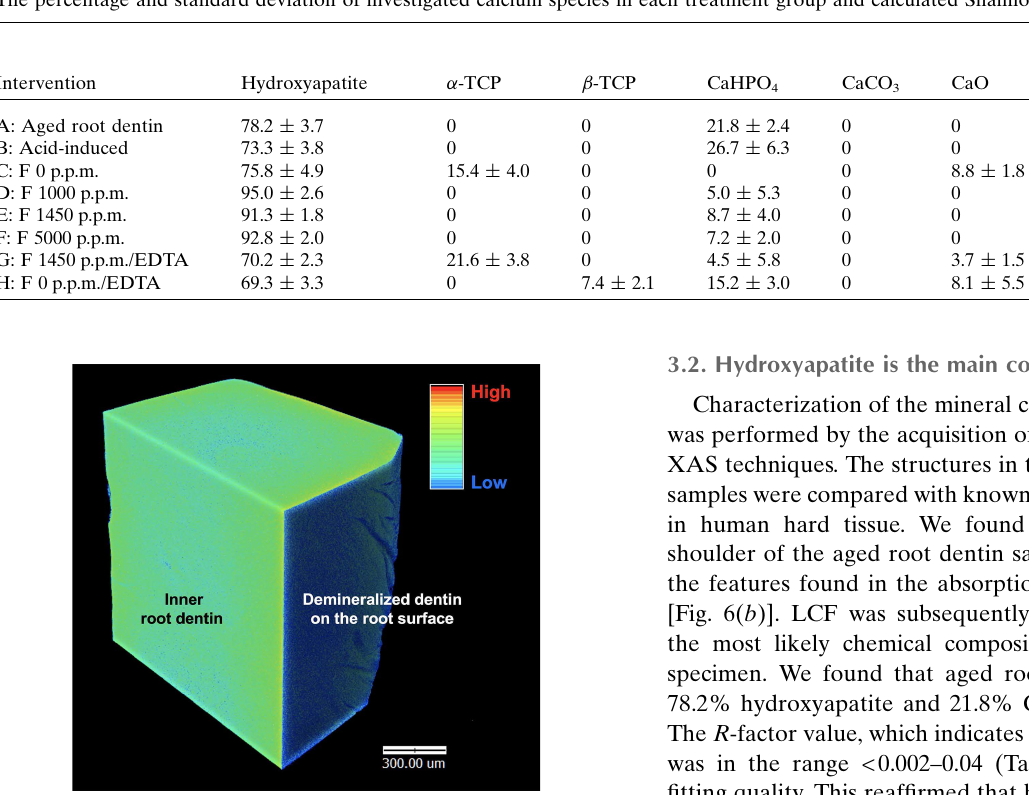
Figure 4 m CT visualization of the demineralized area in the acid-induced group. Induction of surface mineral loss by acidic environment. Colors were assigned according to the density values of each voxel, with higher density values represented by darker colors and low density values by lighter colors.